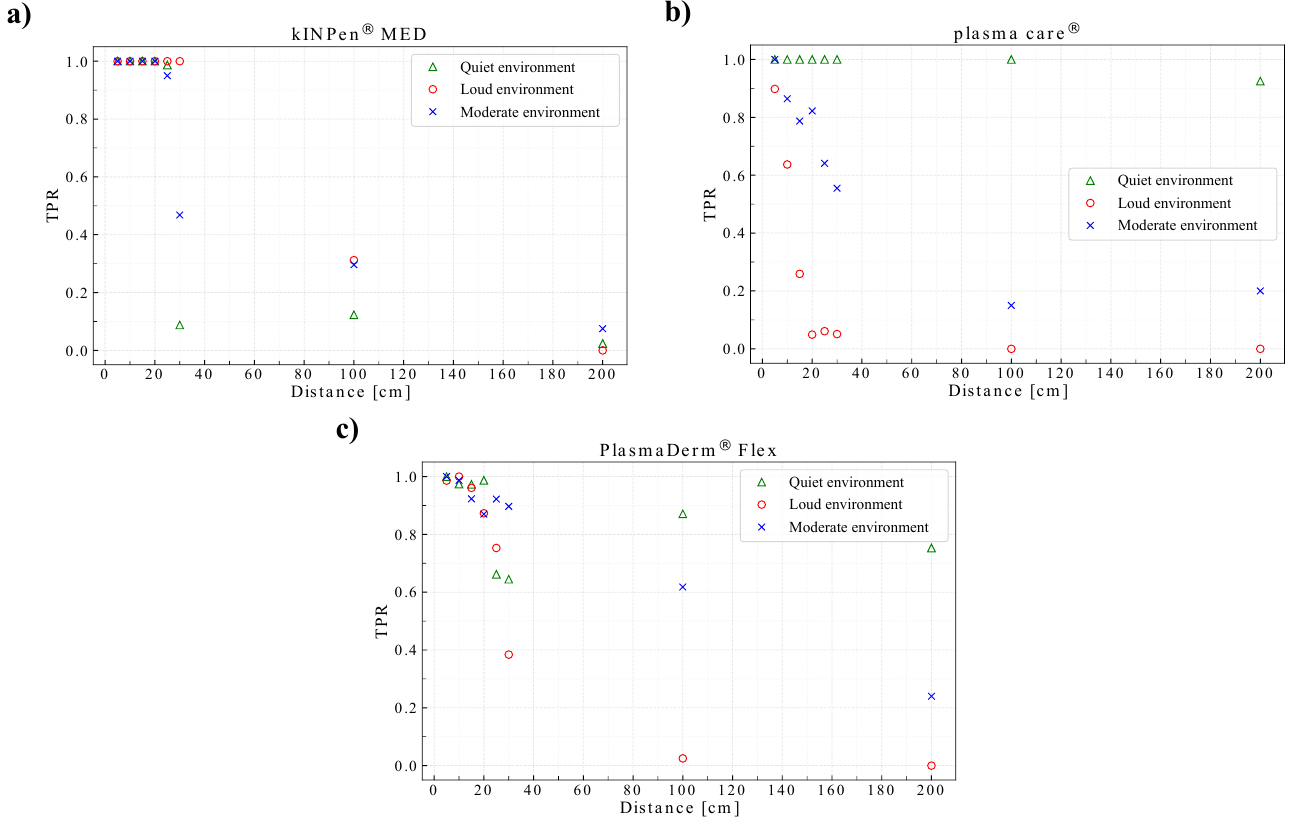
Figure 9. Sensitivity (TPR) of the detection system tested on the ( a ) kINPen ® MED, ( b ) plasma care ® , ( c ) PlasmaDerm ® Flex